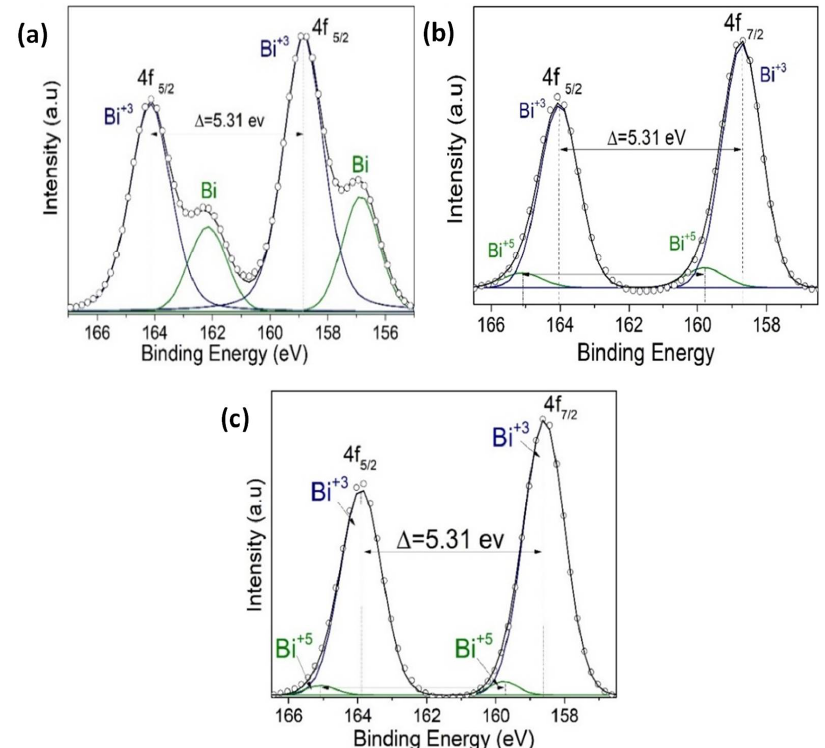
Figure 11. ( a ) An XPS narrow scan of Bi 4f signals for ( a ) BFO/SrTiO 3 , ( b ) BFO/VO 2 /Al 2 O 3 with a BFO of 30 nm, and ( c ) BFO/VO 2 /Al 2 O 3 with a BFO of 60 nm.